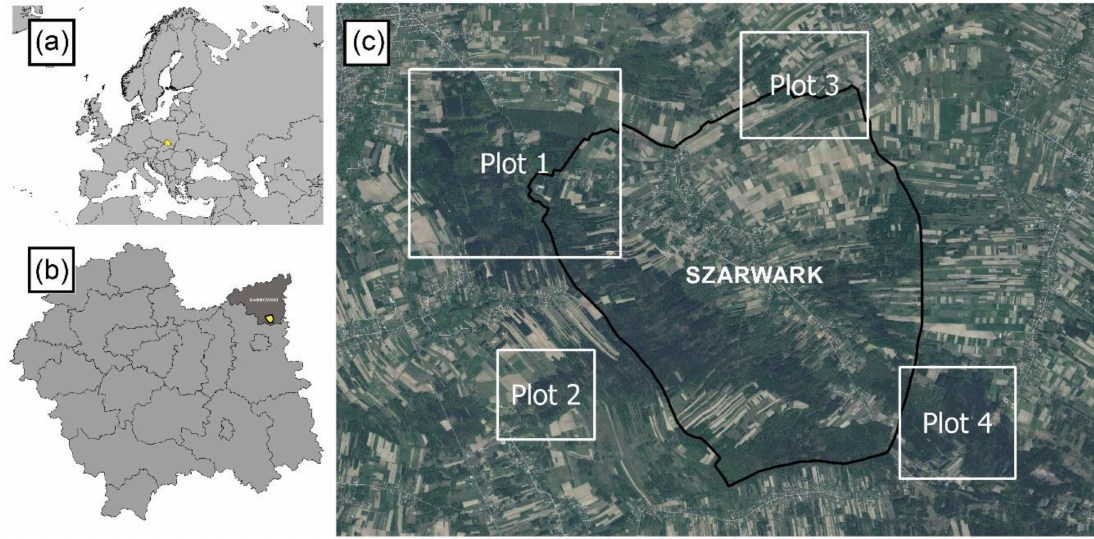
Figure 1. Location of the study area ( c ) in Europe ( a ), and the Małopolskie Voivodeship ( b